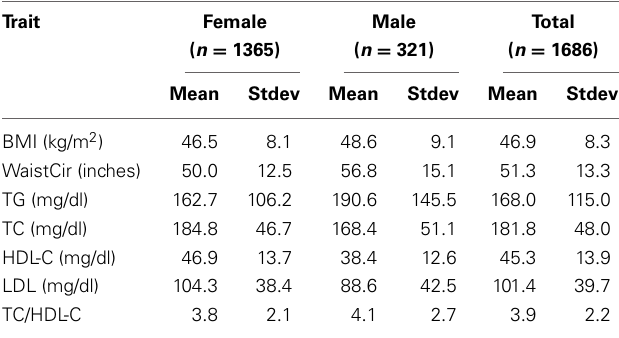
Table 1 | Demographic and laboratory